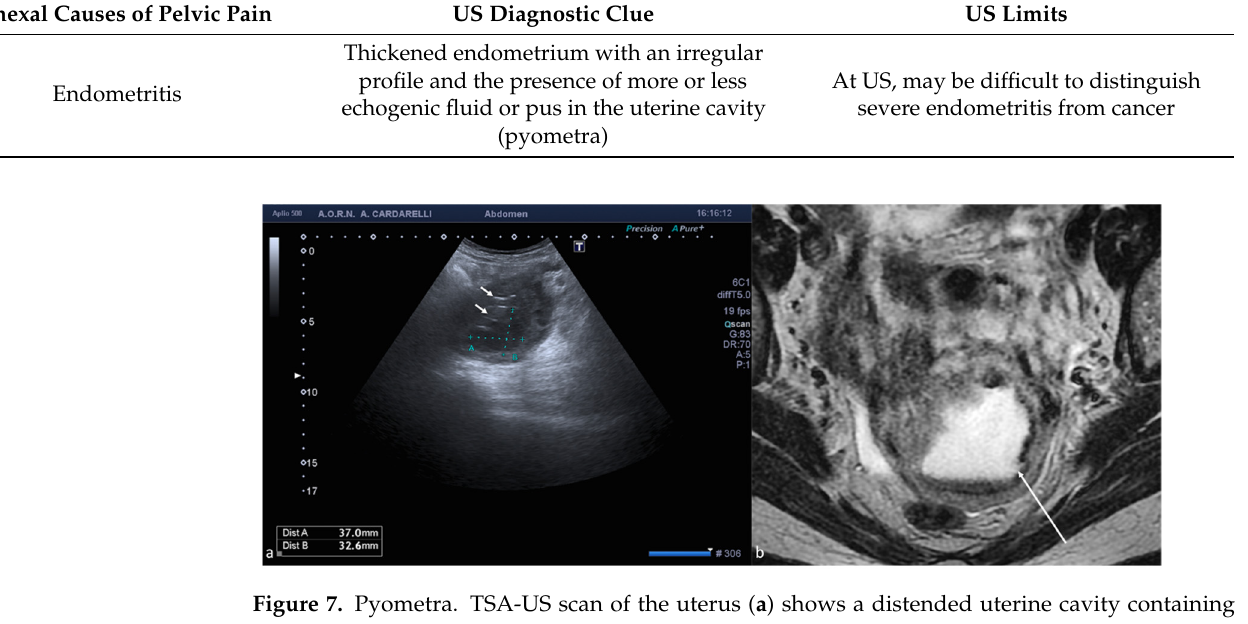
Table 6. Endometritis US diagnostic clue.